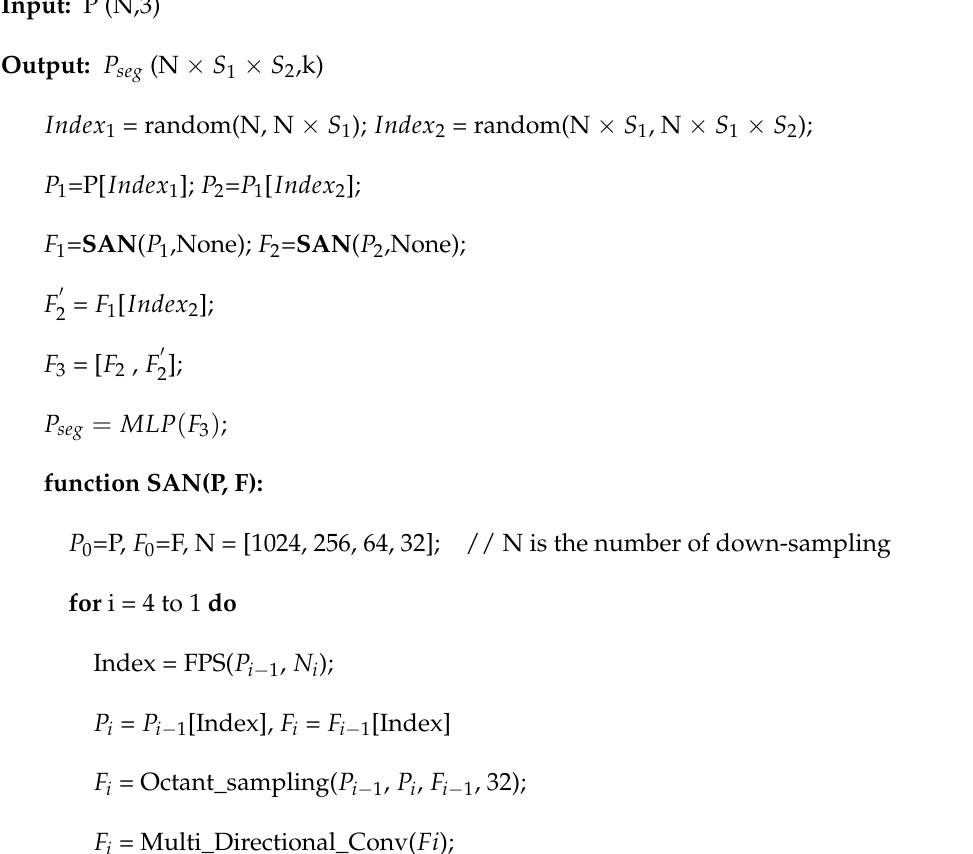
Algorithm 1 Multi-Scale Feature Fusion Semantic Segmentation